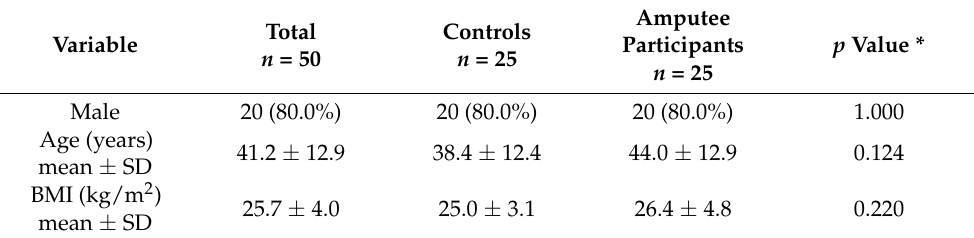
Table 1. Sociodemographic characteristics of participants according to study group.